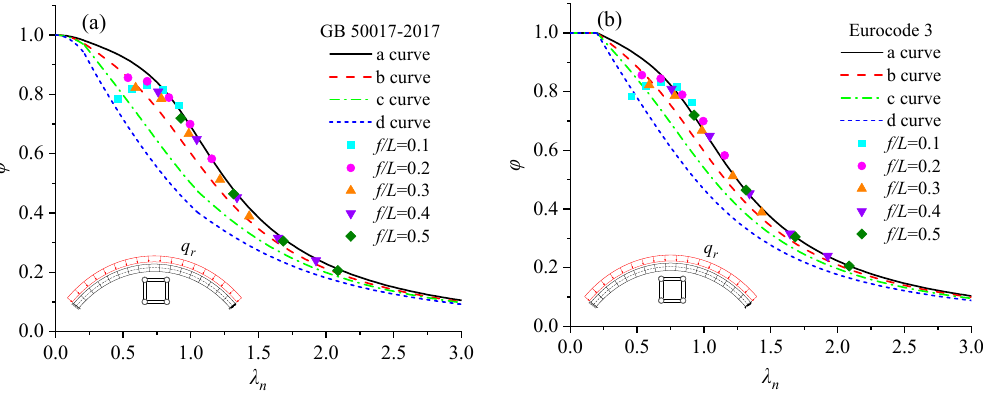
Figure 14. Design curves and numerically obtained reduction factors for the end-fixed Vierendeel truss arches under FSURLs. ( a ) result of FE and GB 50017. ( b ) result of FE and Eurocode 3.